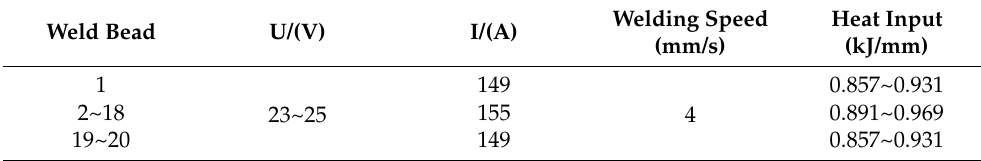
Figure 1. S11306 schematic diagram of welded joint. Table 3. Welding process parameters .